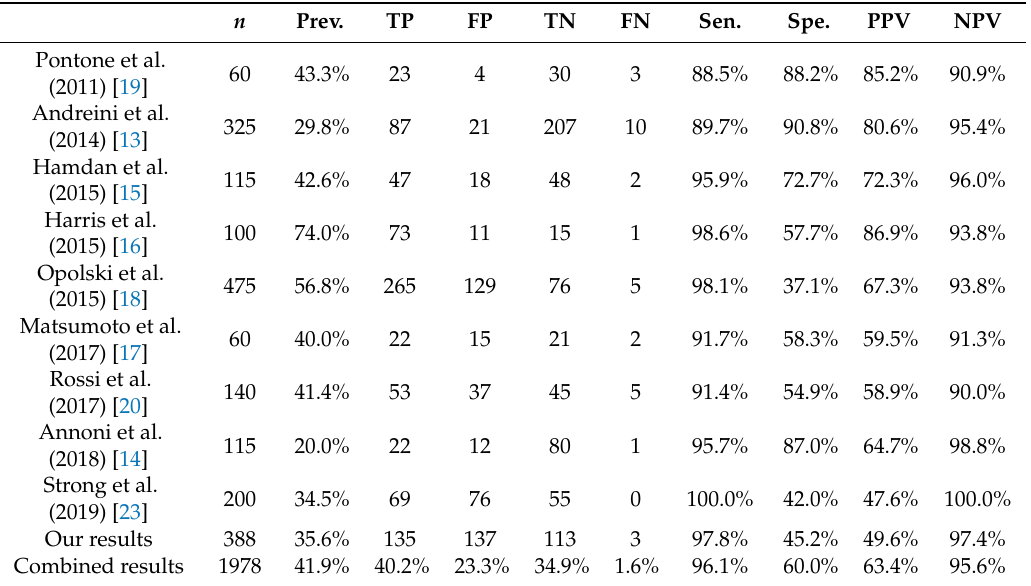
Table 7. Diagnostic performance of cCTA per patient for detecting relevant CAD in the literature. n Prev. TP FP TN FN